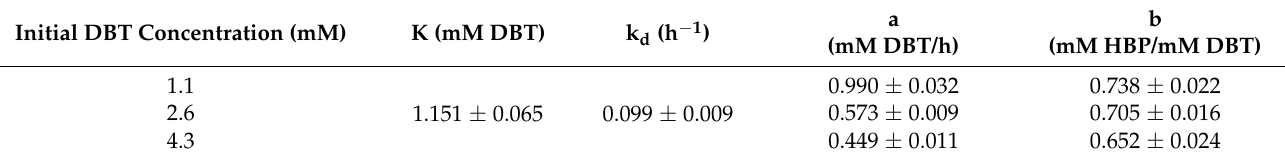
Table 1. Kinetic constants for BDT consumption and 2-HBP production (Equations (6) and (7)). Initial DBT Concentration